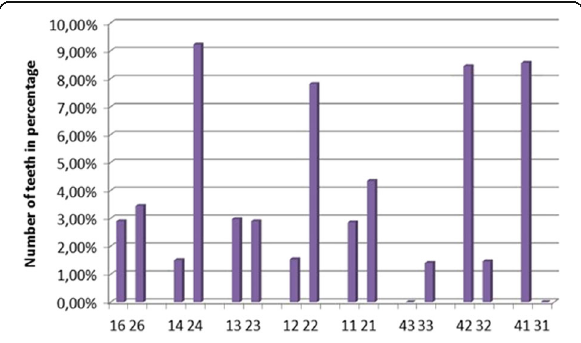
Fig. 4 Percentage of teeth affected by severe RR (rRCR ≤